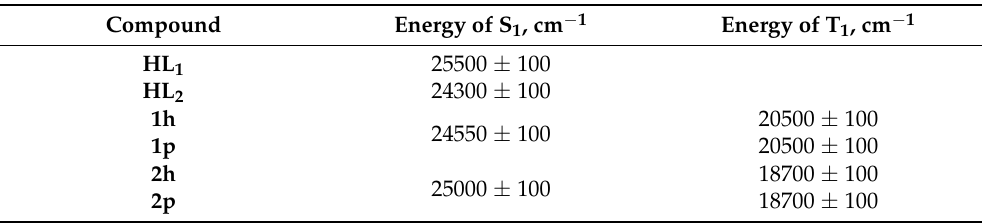
Table 1. The energies of the first excited singlet level S 1 for complexes 1h – 2p and free ligands HL 1 and HL 2 .